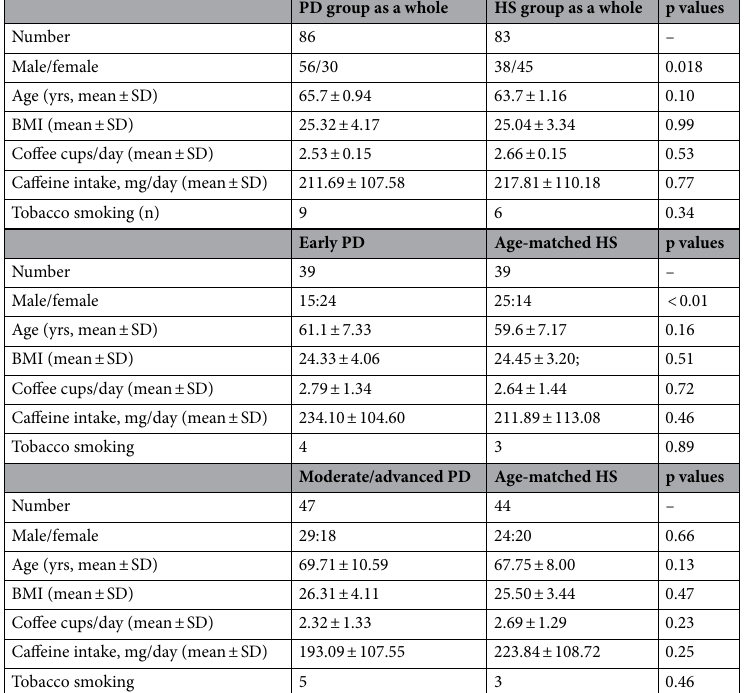
Table 3. Participant demographic and environmental